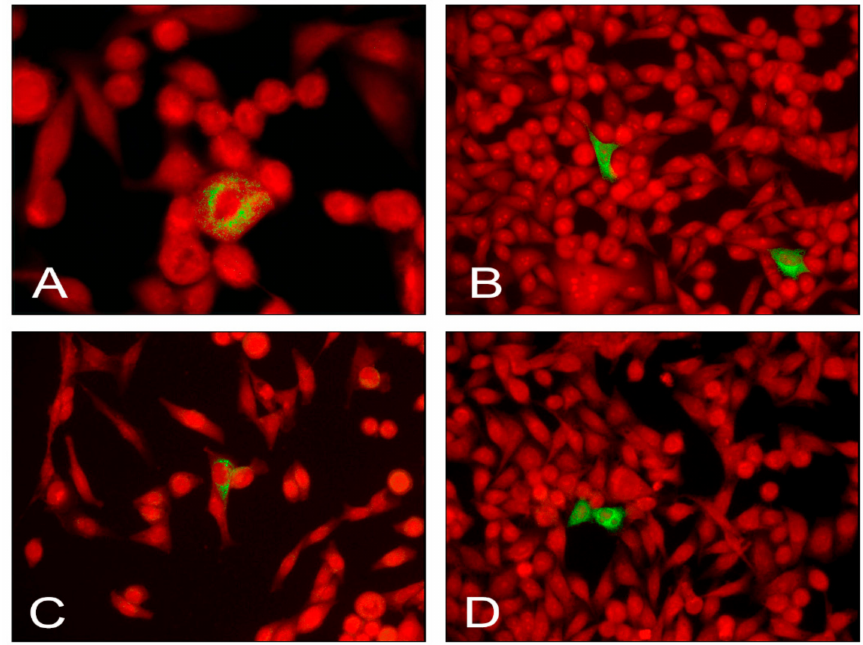
Figure 1. Green immunofluorescent staining of the enteroviral capsid protein VP1 (MAb 6-E9/2) in the AV3 cell line infected with persistent enterovirus (EV) strains isolated from AITD cases. Red, Evans Blue counterstaining. EV strains from cases T21 ( A ), T23 ( B ), T148 ( C ), T131 ( D ). Original magnification: 40 × , A; 20 × , B, C,